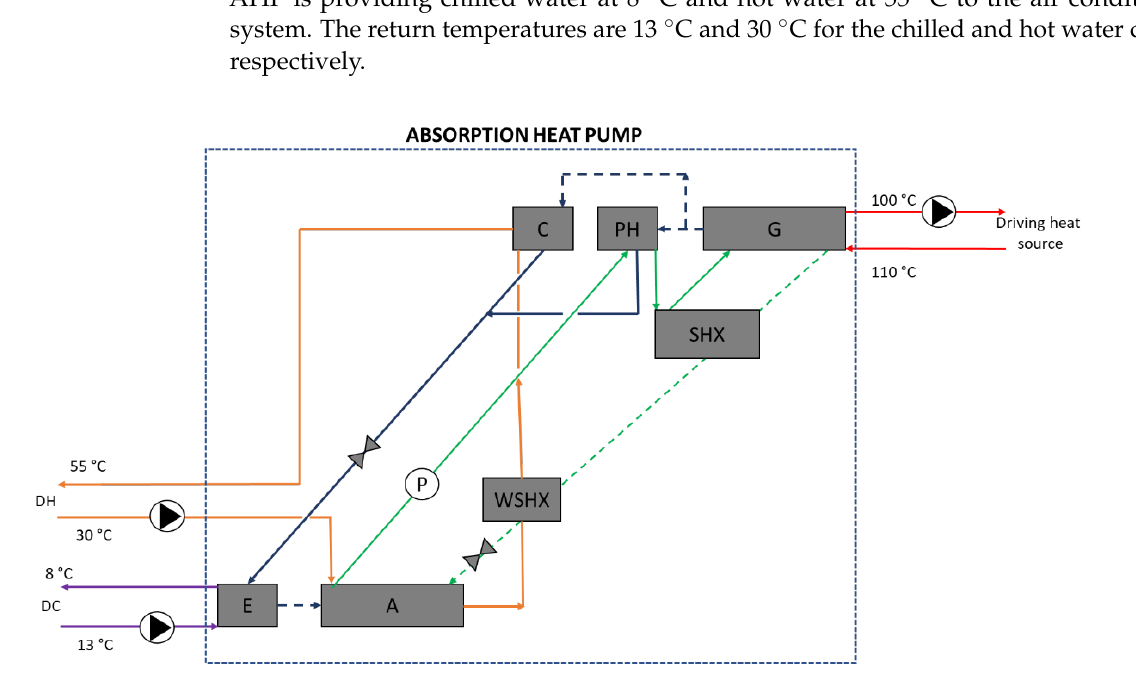
Figure 6. Layout for the simultaneous heating and cooling for air conditioning applications.